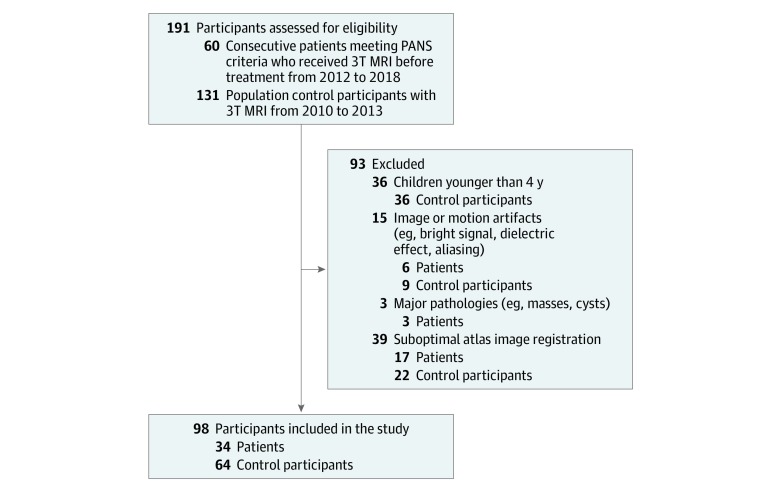
Participant Flow Diagram With Selection and Exclusion CriteriaSixty patients diagnosed as having pediatric acute-onset neuropsychiatric syndrome (PANS) and 131 control participants were selected for this case-control study. Thirty-four patients and 64 control participants were included in the final analysis. MRI indicates magnetic resonance imaging.